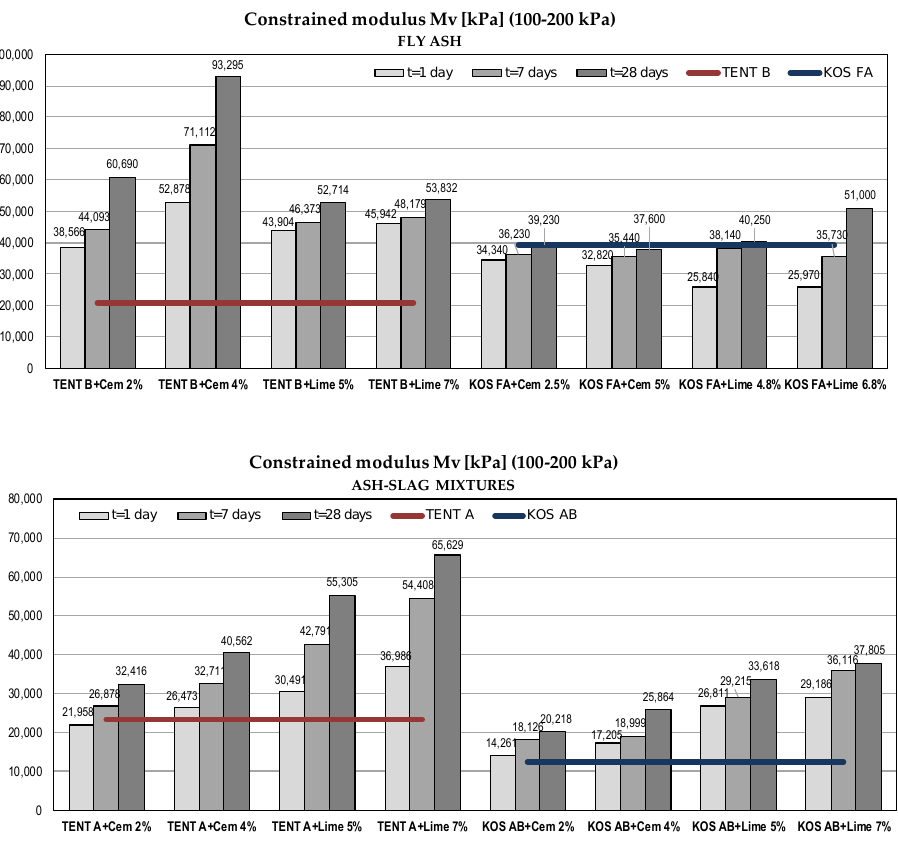
Figure 10. Compressibility parameters of waste materials with binders.